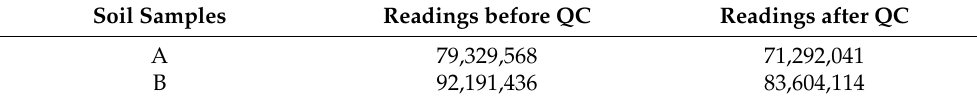
Table 2. The number of raw readings in samples before and after preprocessing (Quality Control). Soil Samples Readings before QC Readings after QC A